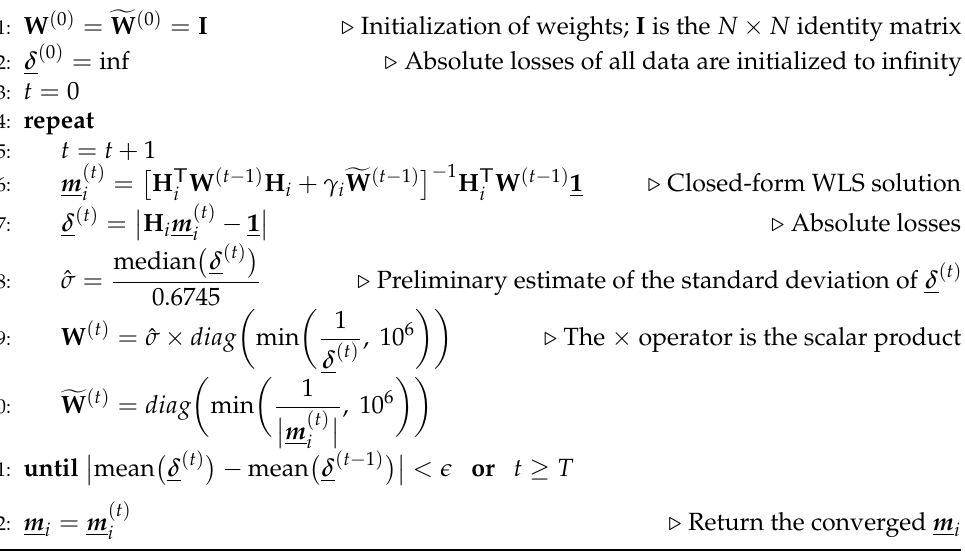
Algorithm 1 Solving RELAD regression (Equation (24)) by IRLS algorithm.